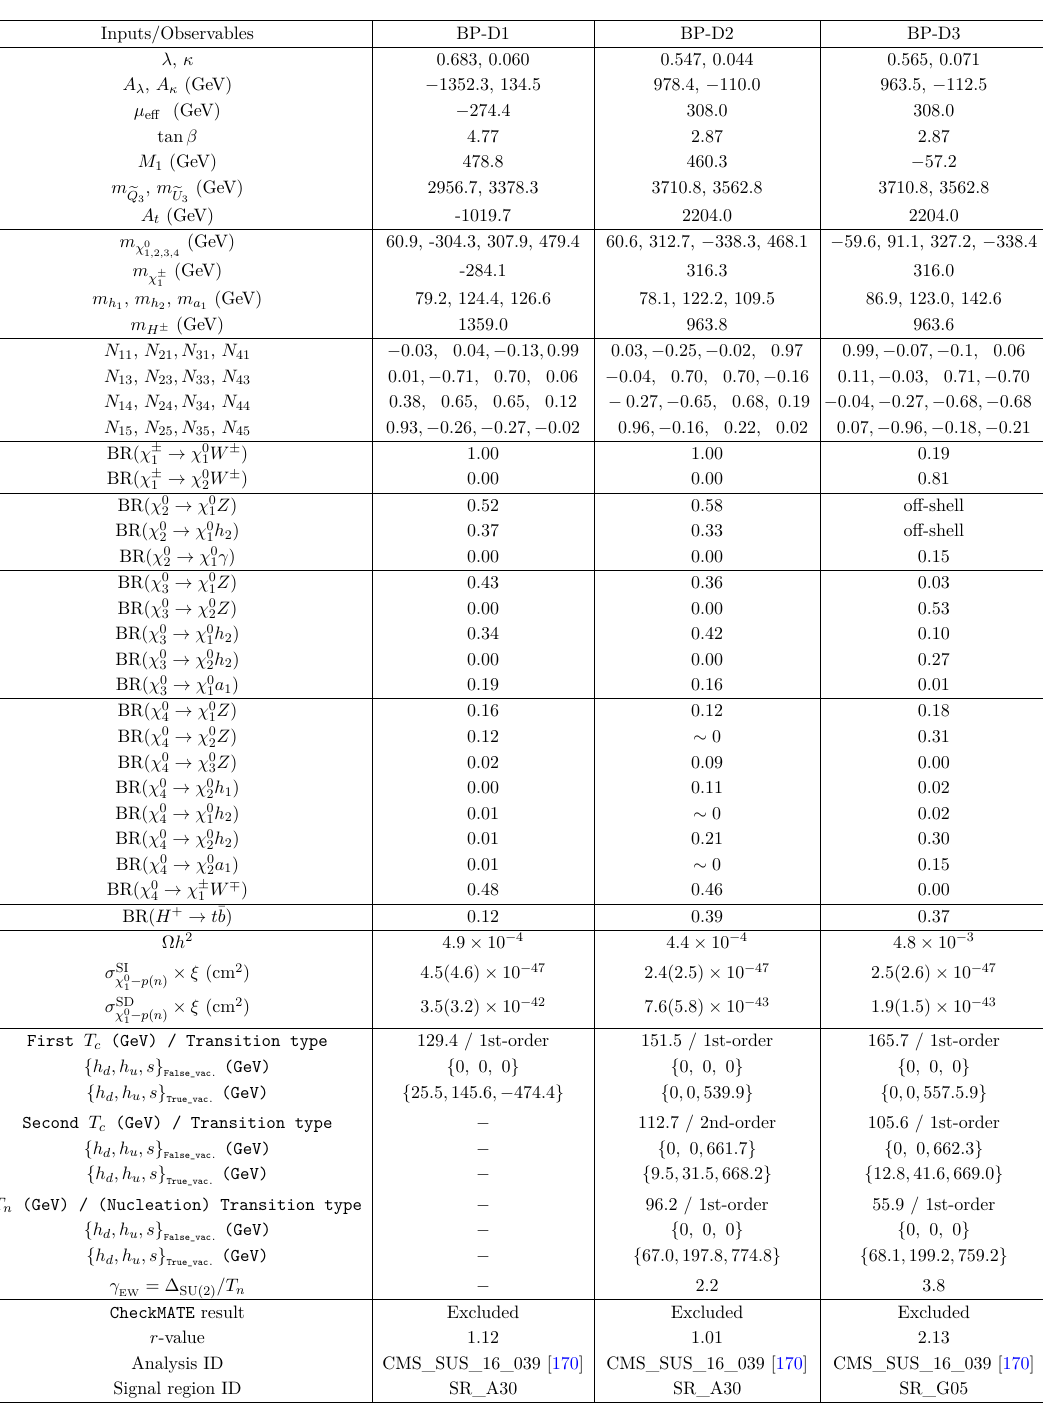
Table 3. Benchmark scenarios allowed by all relevant theoretical and experimental constraints (see text for details) except for those from the LHC searches for the electroweakinos. Shown are the various relevant masses, mixings, branching fractions along with the values of DM observables and details of the EWPT. The most sensitive LHC signal regions that rule out these scenarios, along with the LHC analyses they belong to, are also presented. Other fixed parameters are as